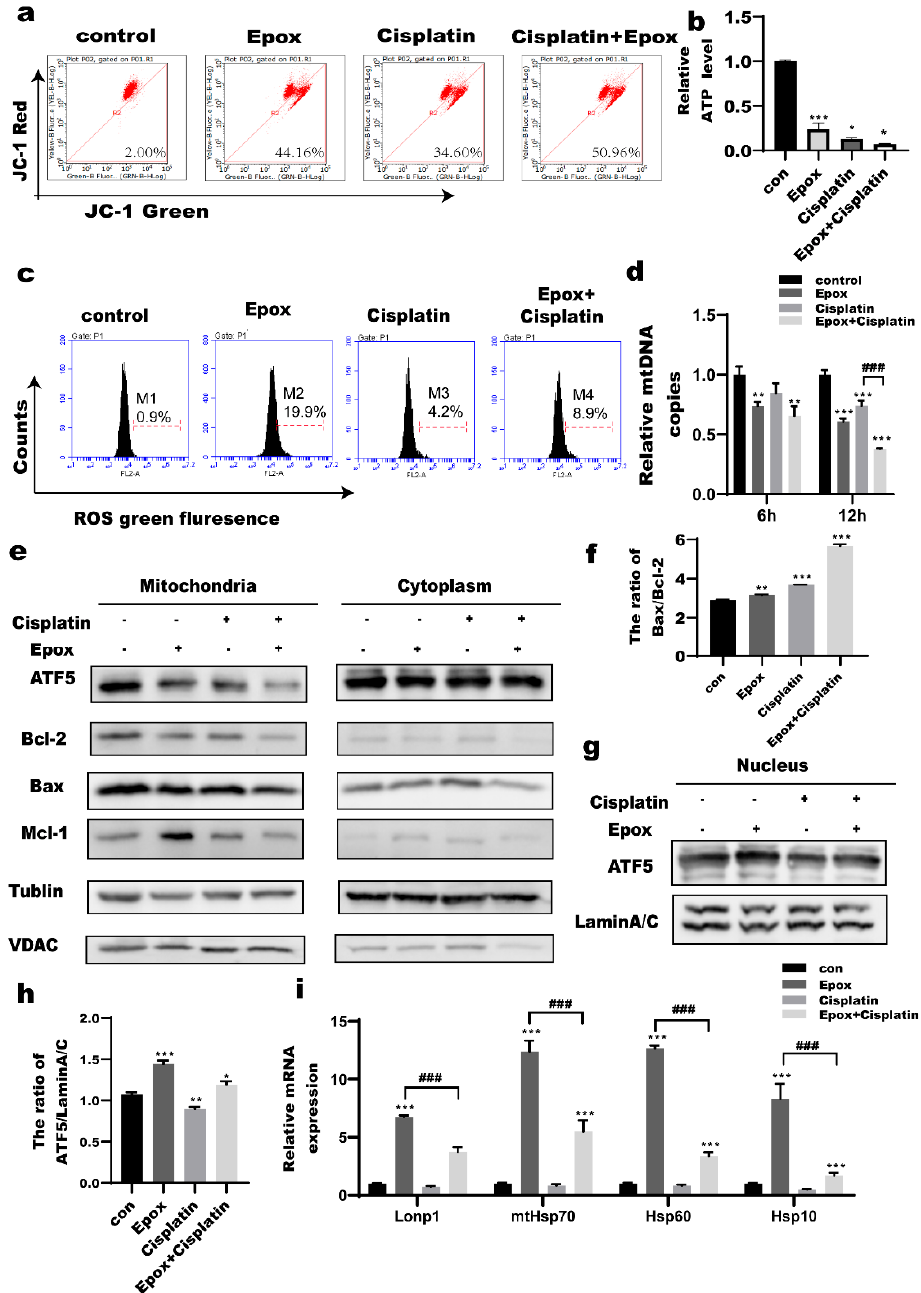
Figure 2. Epox − induced proteasome inhibition leads to mitochondrial dysfunction and UPR mt in ovarian cancer cells. ( a ) A2780 cells were treated with epox (100 nM) or CDDP (2 µg/mL) or both for 24 h. Mitochondrial membrane potential detected by flow cytometry. ( b ) A2780 cells were treated with epox (100 nM) or CDDP (2 µg/mL) or both for 12 h. ATP production was measured based on total protein content amount. ( c ) A2780 cells were treated with epox (100 nM) or CDDP (2 µg/mL) or both for 12 h. Mitochondrial ROS generation was detected by flow cytometry detection. ( d ) A2780 cells were treated with epox (100 nM) or CDDP (2 µg/mL) or both for 12 h. Quantitative RT-PCR validation of mitochondrial DNA (mtDNA) copy number. ( e ) A2780 cells were treated with epox (100 nM) or CDDP (2 µg/mL) or both for 12 h. Protein levels of activating transcription factor 5(ATF5), apoptosis-related proteins in mitochondria were detected by western blot. ( f ) Quantitation of (B cell lymphoma-2)Bax/( B cell lymphoma-2)Bcl-2. ( g , h ) ATF5 nuclear protein levels detected by western blot (12 h). ( i )Quantitative RT-PCR detection of mitochondrial unfolded protein response ( UPR mt ) related mRNAs level. * p < 0.05 vs. con, ** p < 0.01 vs. con, *** p < 0.001 vs. con, ### p < 0.001 vs. Epox + Cisplatin.